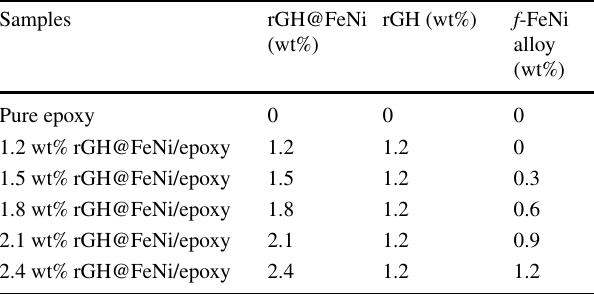
Table 1 Filler mass fraction of rGH@FeNi/epoxy composites